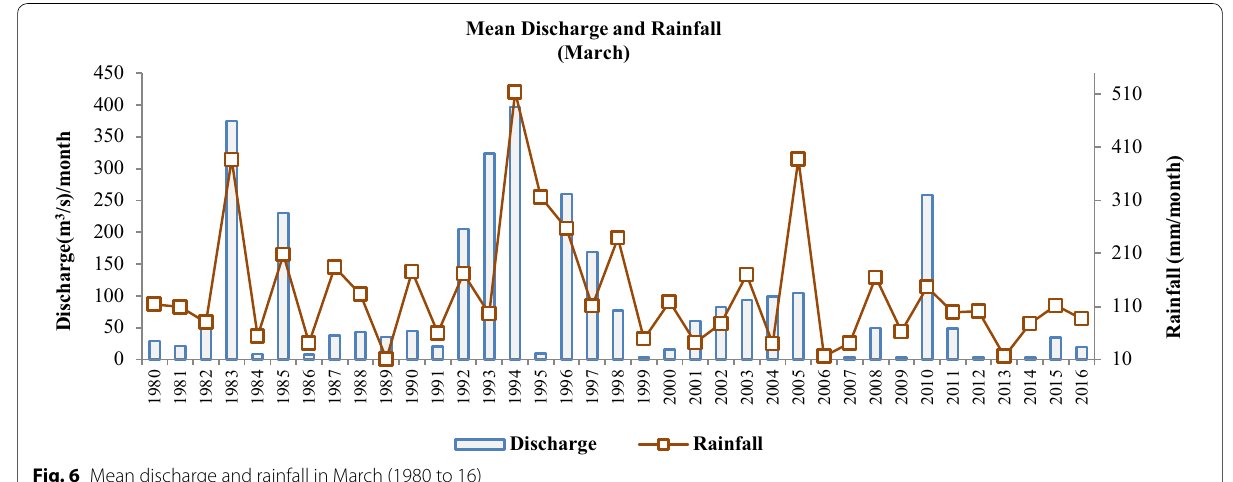
Fig. 6 Mean discharge and rainfall in March (1980 to